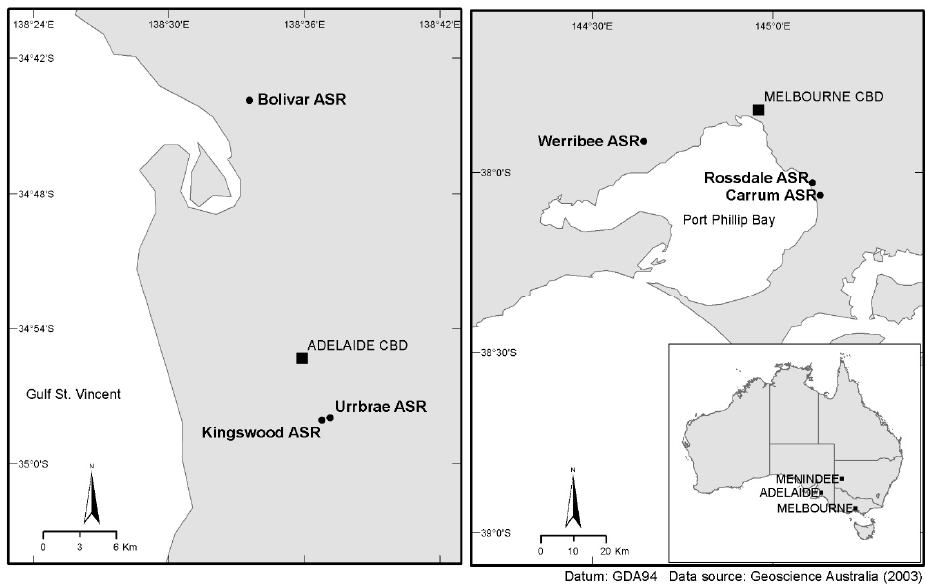
Figure 1. Location of the ASR study sites referred to in this paper.